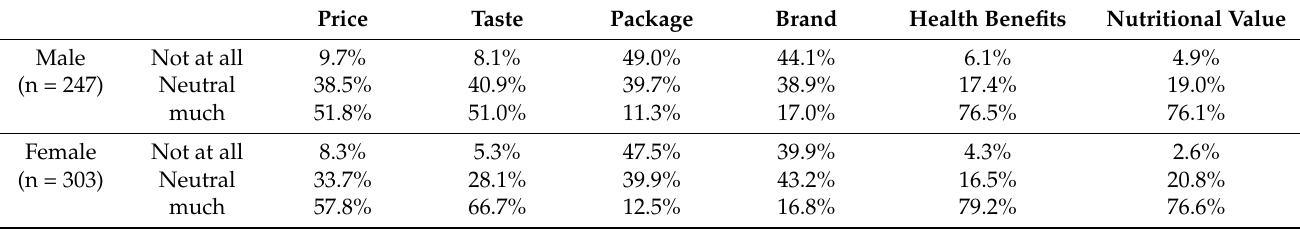
Table 5. % Percentages of participants replies regarding how (not at all, neutral, much) price, taste, package, brand, reported health benefits and nutritional value affects their functional food purchasing